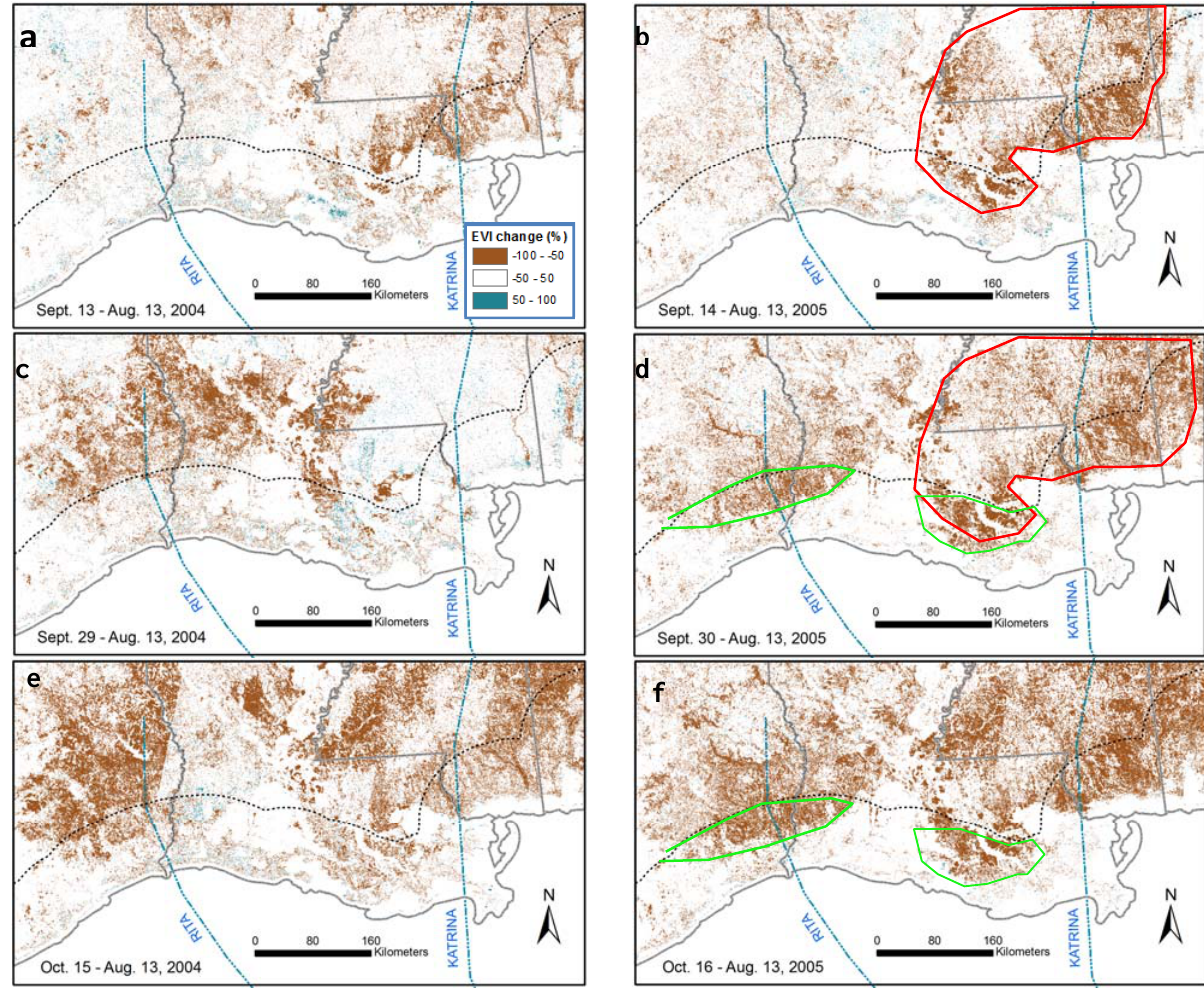
Figure 3. Greater than 45% decrease of the MODIS EVI values between two dates in the same year as shown on the maps. The images on the left column as references, display the changes without hurricane disturbance. The maps on the right column represent the changes after Hurricane Katrina and Rita disturbance.